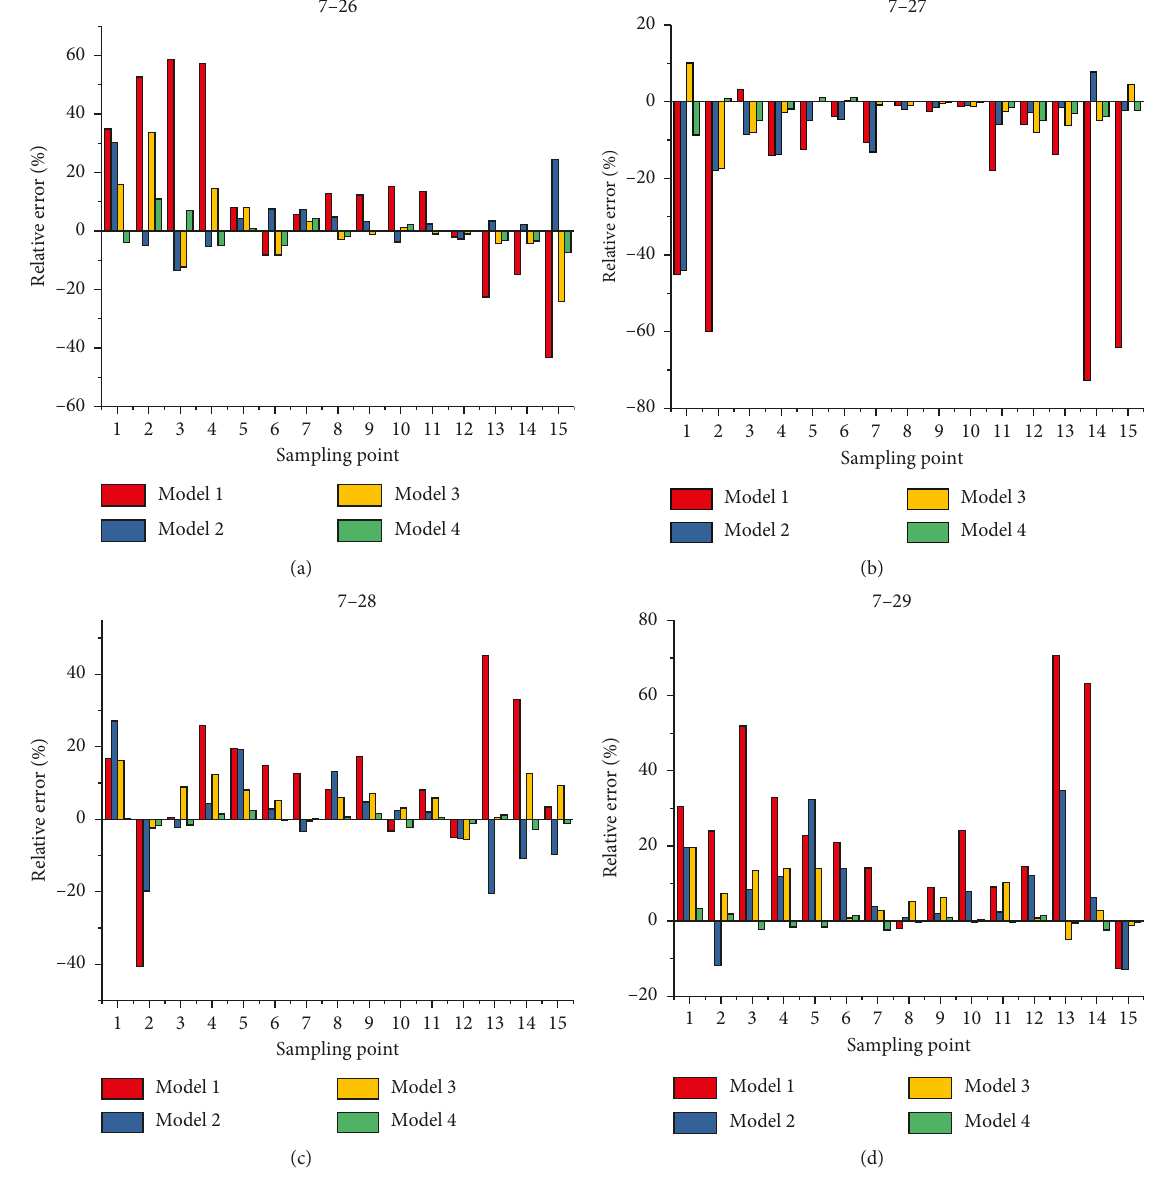
Figure 5: Comparison of results.